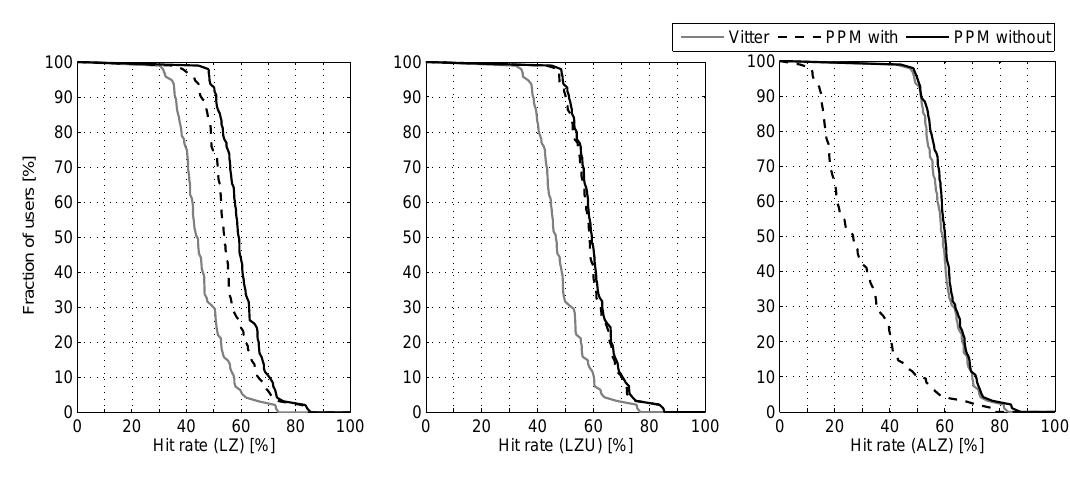
Figure 3. Comparison of hit rate attained when fixing the tree updating scheme and varying the probability calculation method.